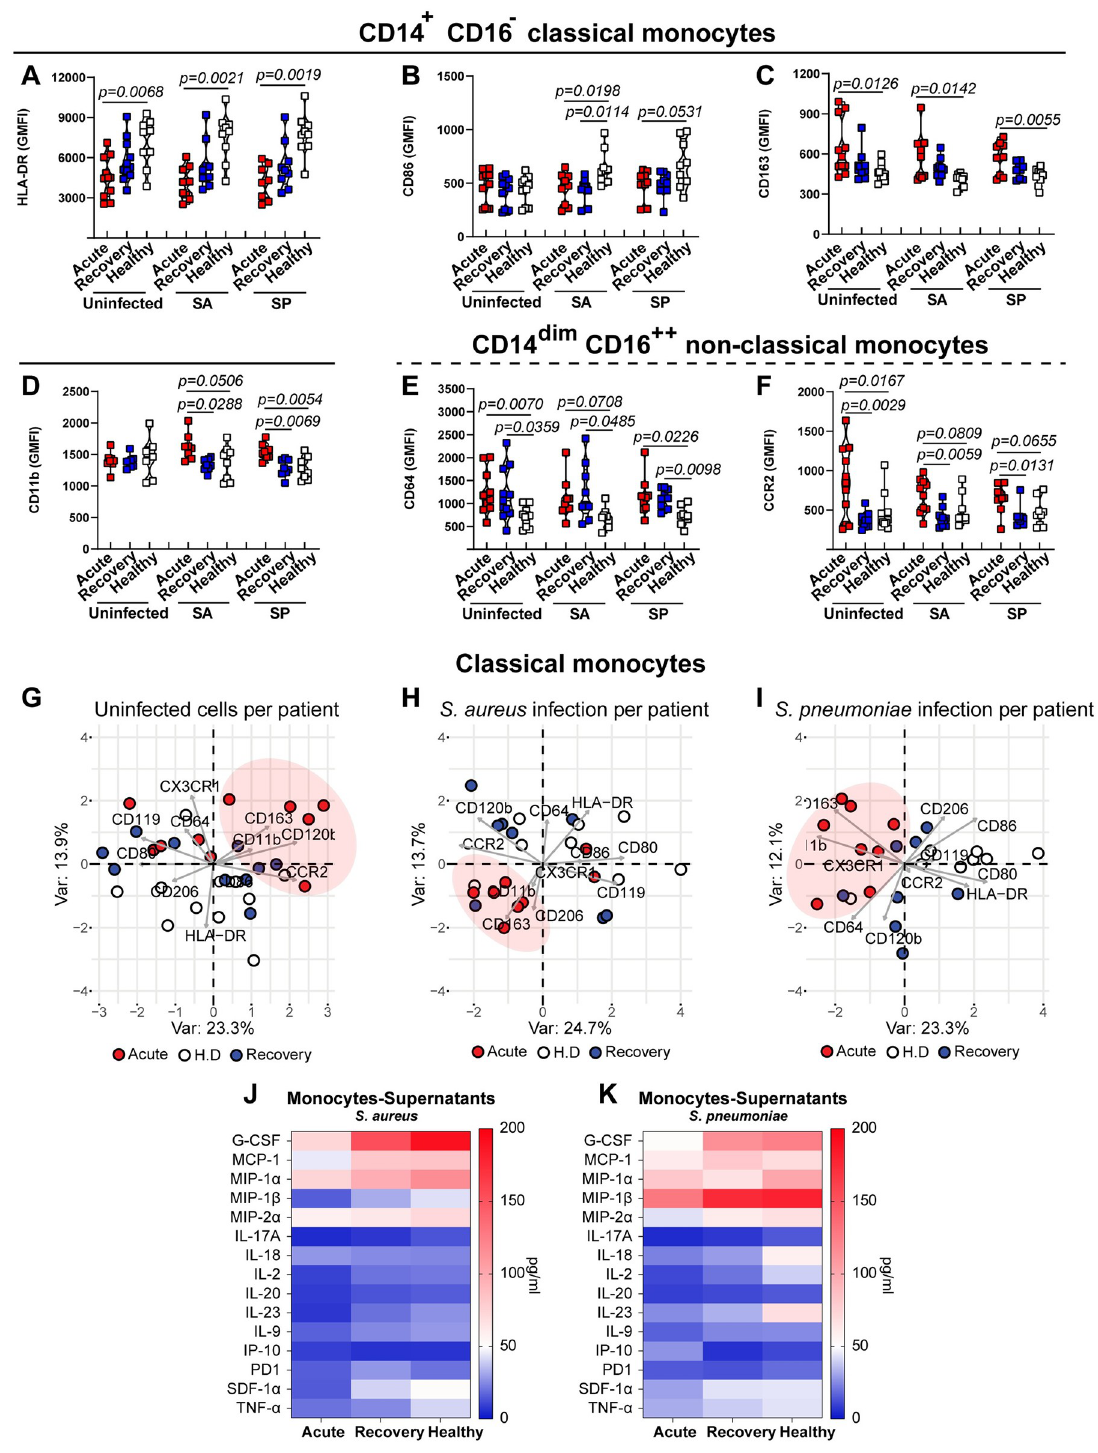
Fig 6. Phenotypic characterization of surface markers and secreted cytokines in monocytes upon bacterial challenge. ( A-F ) Expression of key surface markers of classical ( A-D ) and non-classical monocytes ( E and F ) from acute- or rec-phase COVID-19 patients or healthy donors pre-exposed to 10% autologous plasma for 3h and subsequently challenged with either SA or SP at MOI 1 or left unchallenged (n = 9–11). ( G-I ) PCA of cell surface phenotype of COVID-19 patients acute- (red) or rec-phase (blue) and healthy donors’ (white) classical monocytes at the basal level without bacterial challenge ( G ), upon SA infection ( H ) or SP infection ( I ). Each symbol